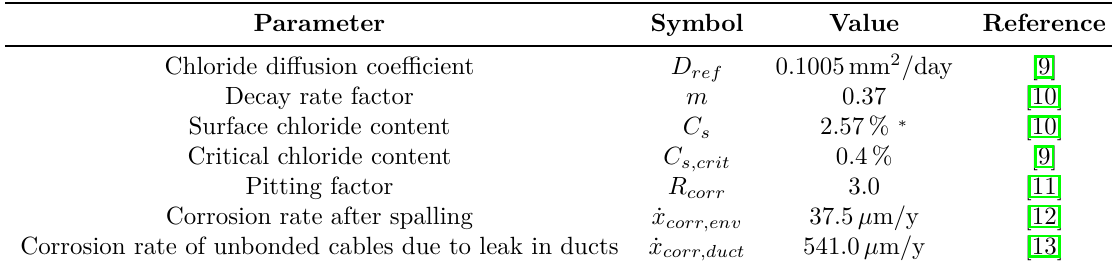
Table 1. Inputs for the chloride ingress and corrosion